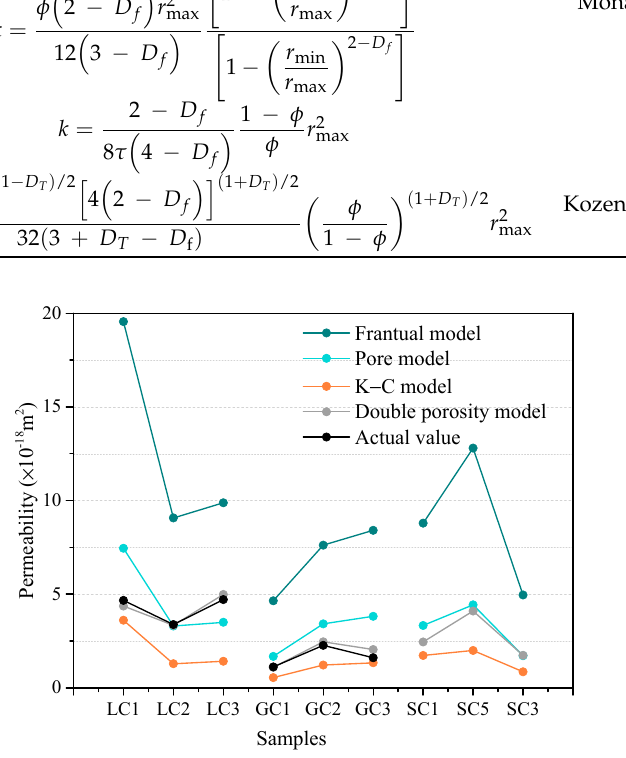
Figure 14. Comparison between measured permeability, the proposed model and other models available in the literature.